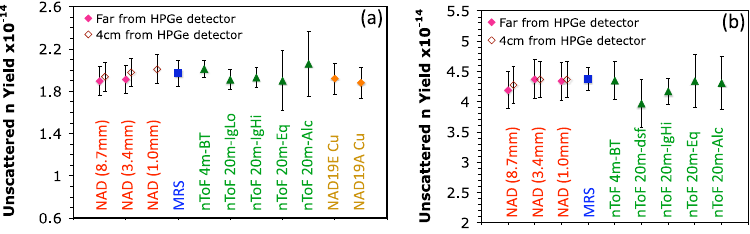
Figure 1. Primary unscattered neutron yield as measured from different diagnostics on two NIF shots: (a) N110217-001, an exploding pusher and (b) N110615-003, a layered DT shot. Well-NAD results (red, leftmost) are shown when the sample was counted both close to and far from the detector. NAD19 results (orange, right) are from copper foils on the equator (E) at (90,174) and in the alcove (A) at (116,315). The Magnetic Recoil Spectrometer (MRS) and neutron Time-of-Flight (nToF) diagnostics are described elsewhere in these